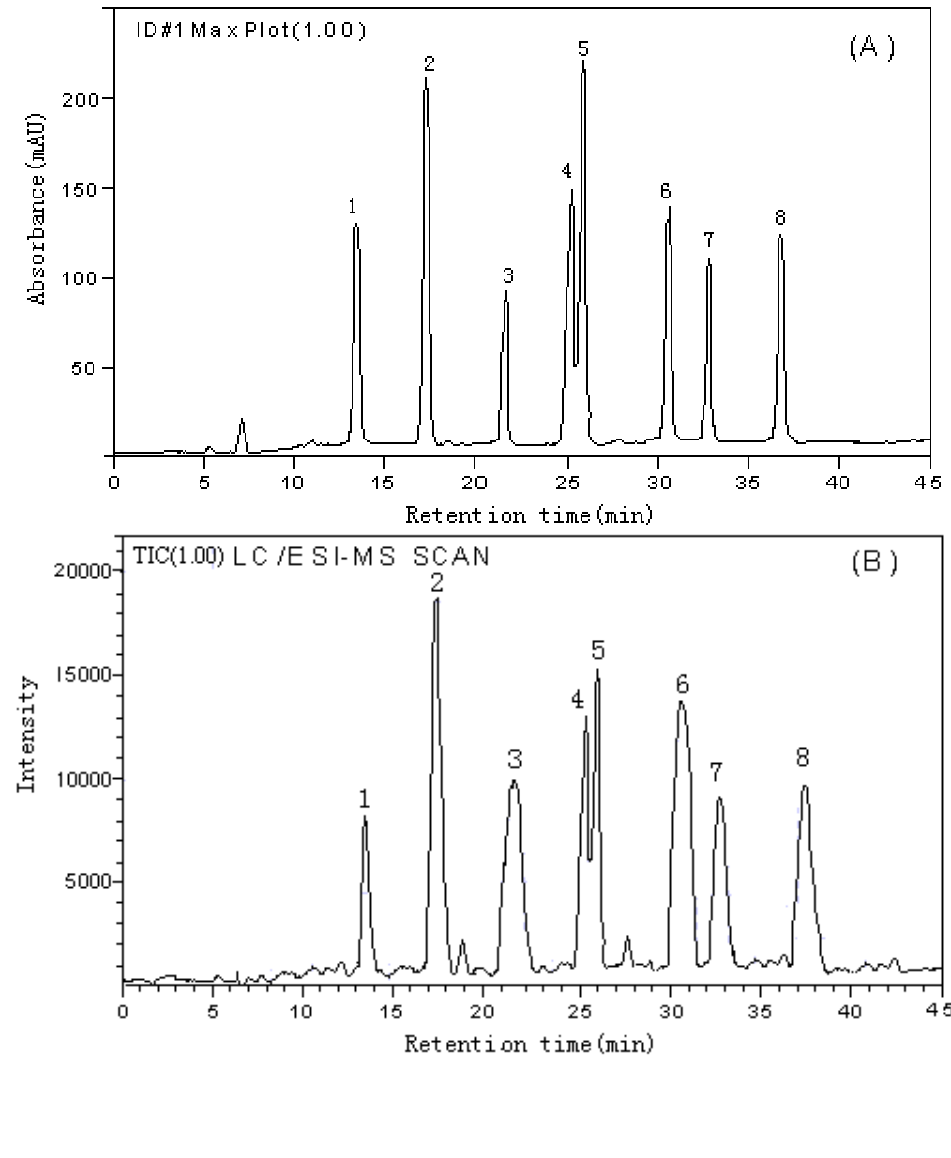
Figure 1. Simultaneous HPLC chromatogram detected with a diode array detector set at 260 nm (A) and LC/ESI-MS total ion chromatograms (TIC) in scan mode (B) of a reference solution of Astragali Radix: (1) calycosin-7- O - β - D -glucoside; (2) ononin; (3) 9- methoxynissolin-3- O - β - D -glucoside; (4)calycosin; (5) isomucronulatol-7- O - β - D -glucoside; (6) formononetin; (7) 9-methoxynissolin; (8)